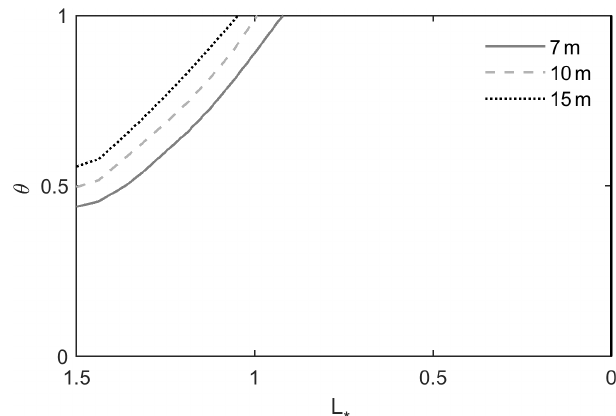
Figure 12. Crossover point location for 7–15m channel depth com- pared to the 5m case, (Su Pri = 24h and L e = 80km). The x axis represents the dimensionless coordinate system of L ∗ = x/L e , and the y axis shows nondimensional river flow